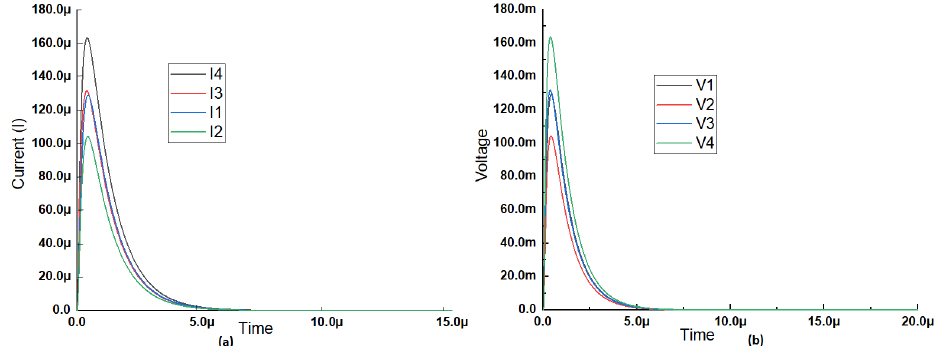
Figure 10. ( a ) Equivalent circuit of SiPM. ( b ) Current pulse generated from scintillation.